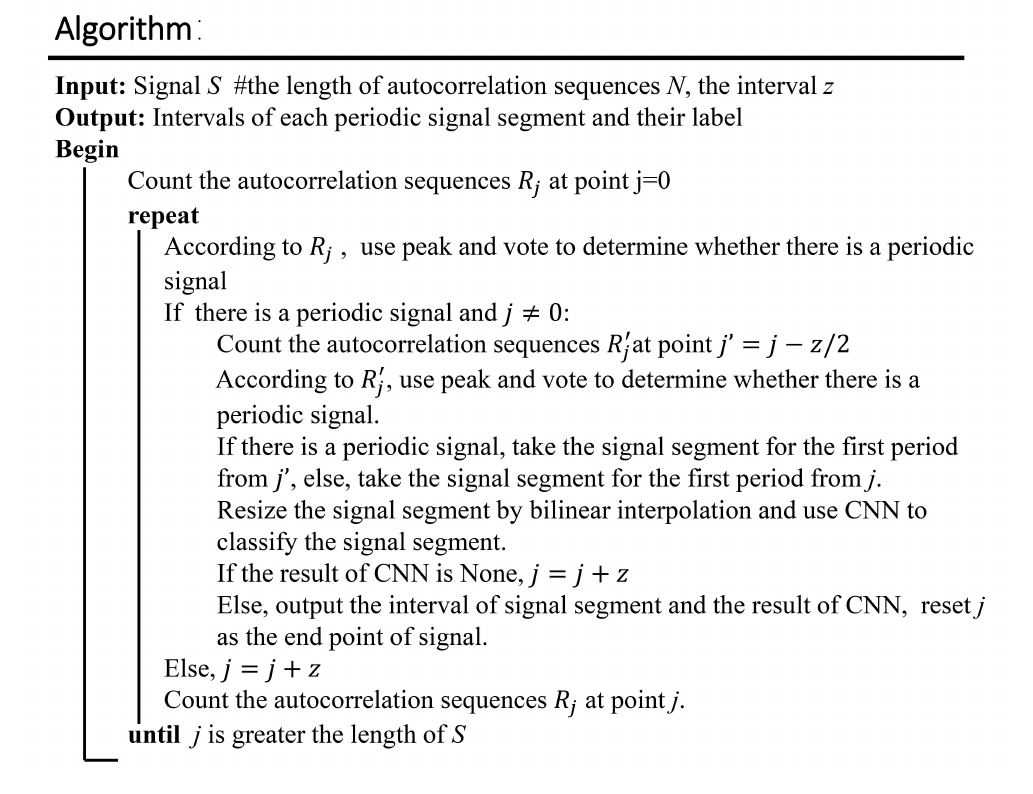
Figure 6. Algorithm of periodic matching based on